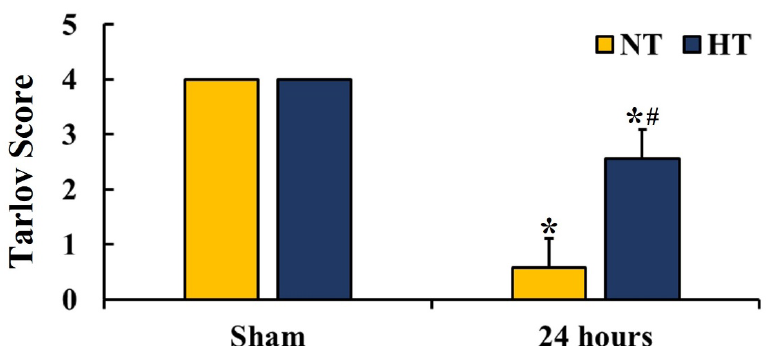
Figure 2. Hindlimb motor function evaluation in the sham-NT, sham-HT, CA-NT, and CA-HT groups at 24 h after CA/ROSC. The rats of the CA-NT and CA-HT groups show hindlimb motor dysfunction, but the CA-HT group shows significantly milder motor dysfunction when compared with the CA-NT group. A high score indicates good motor function. The bars indicate the means ± SD ( n = 6, respectively; * p < 0.05 vs. each sham group, # p < 0.05 vs. corresponding CA-NT group).